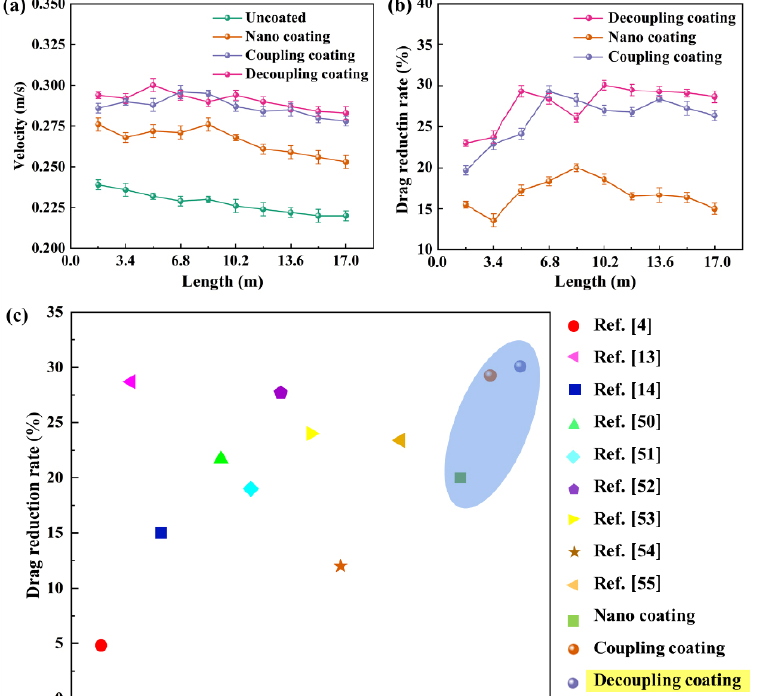
Fig. 11 Sailing tests of ships with and without coatings: (a) velocity; (b) drag reduction rate. (c) Comparison of drag reduction rate of superhydrophobic surfaces in recent years [4, 13, 14,